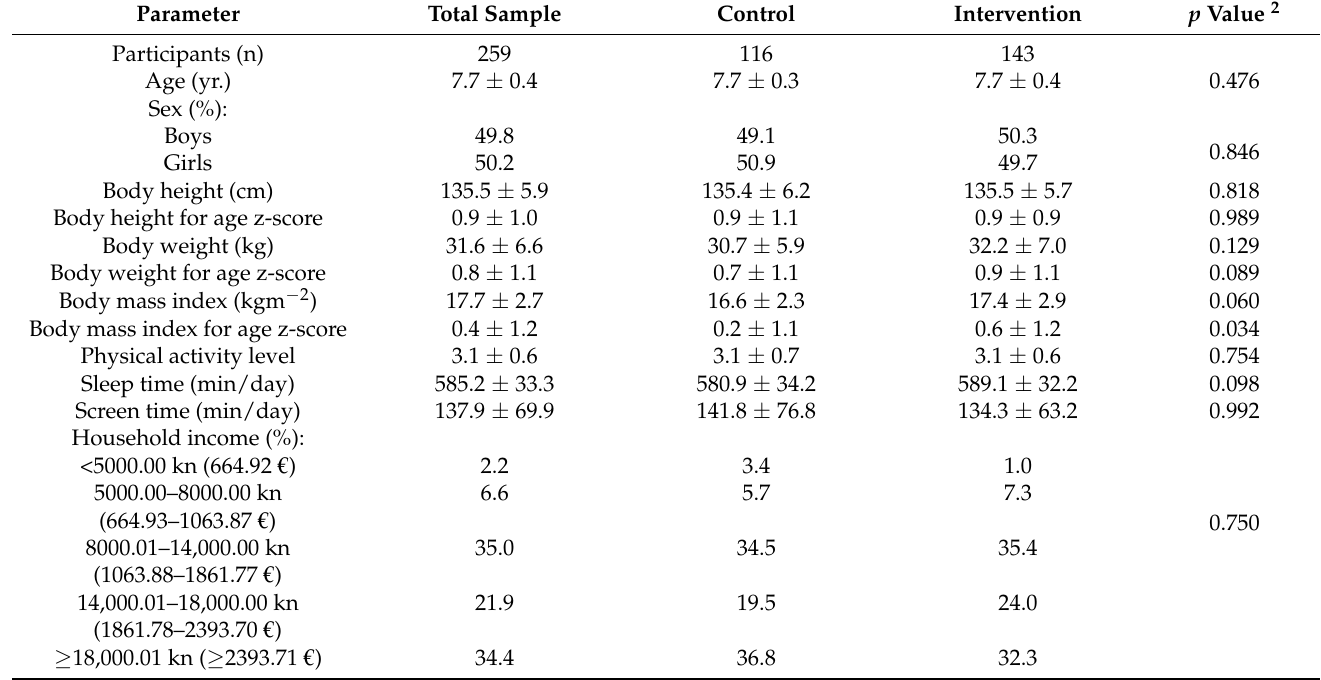
Table 1. Baseline characteristics of the study sample 1 .